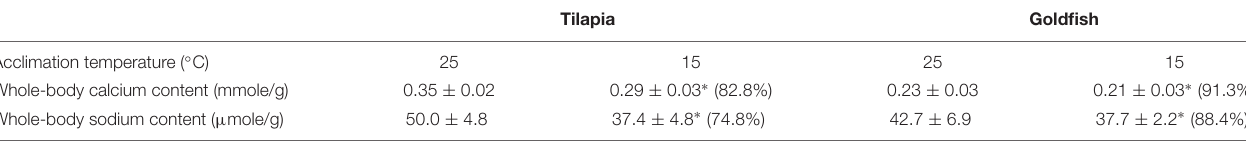
TABLE 1 | Whole-body calcium and sodium content in tilapia and goldfish after 2-week cold acclimation.